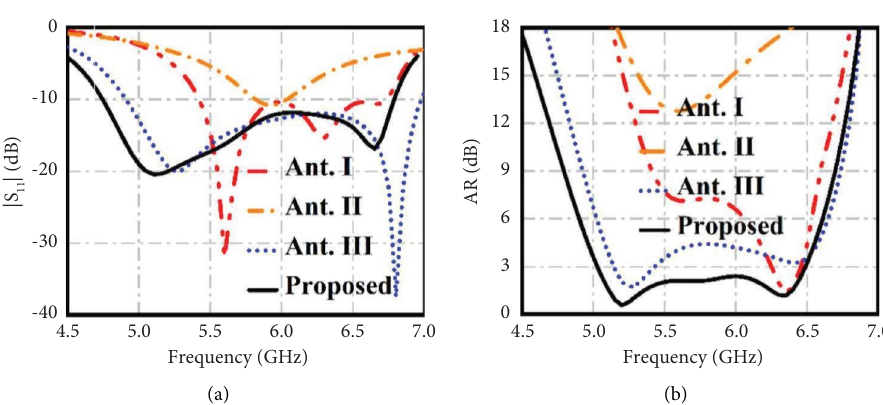
Figure 3: Corresponding | S 11 | curves and AR curves for diferent step-by-step antennas. (a) | S 11 | curves and (b) AR